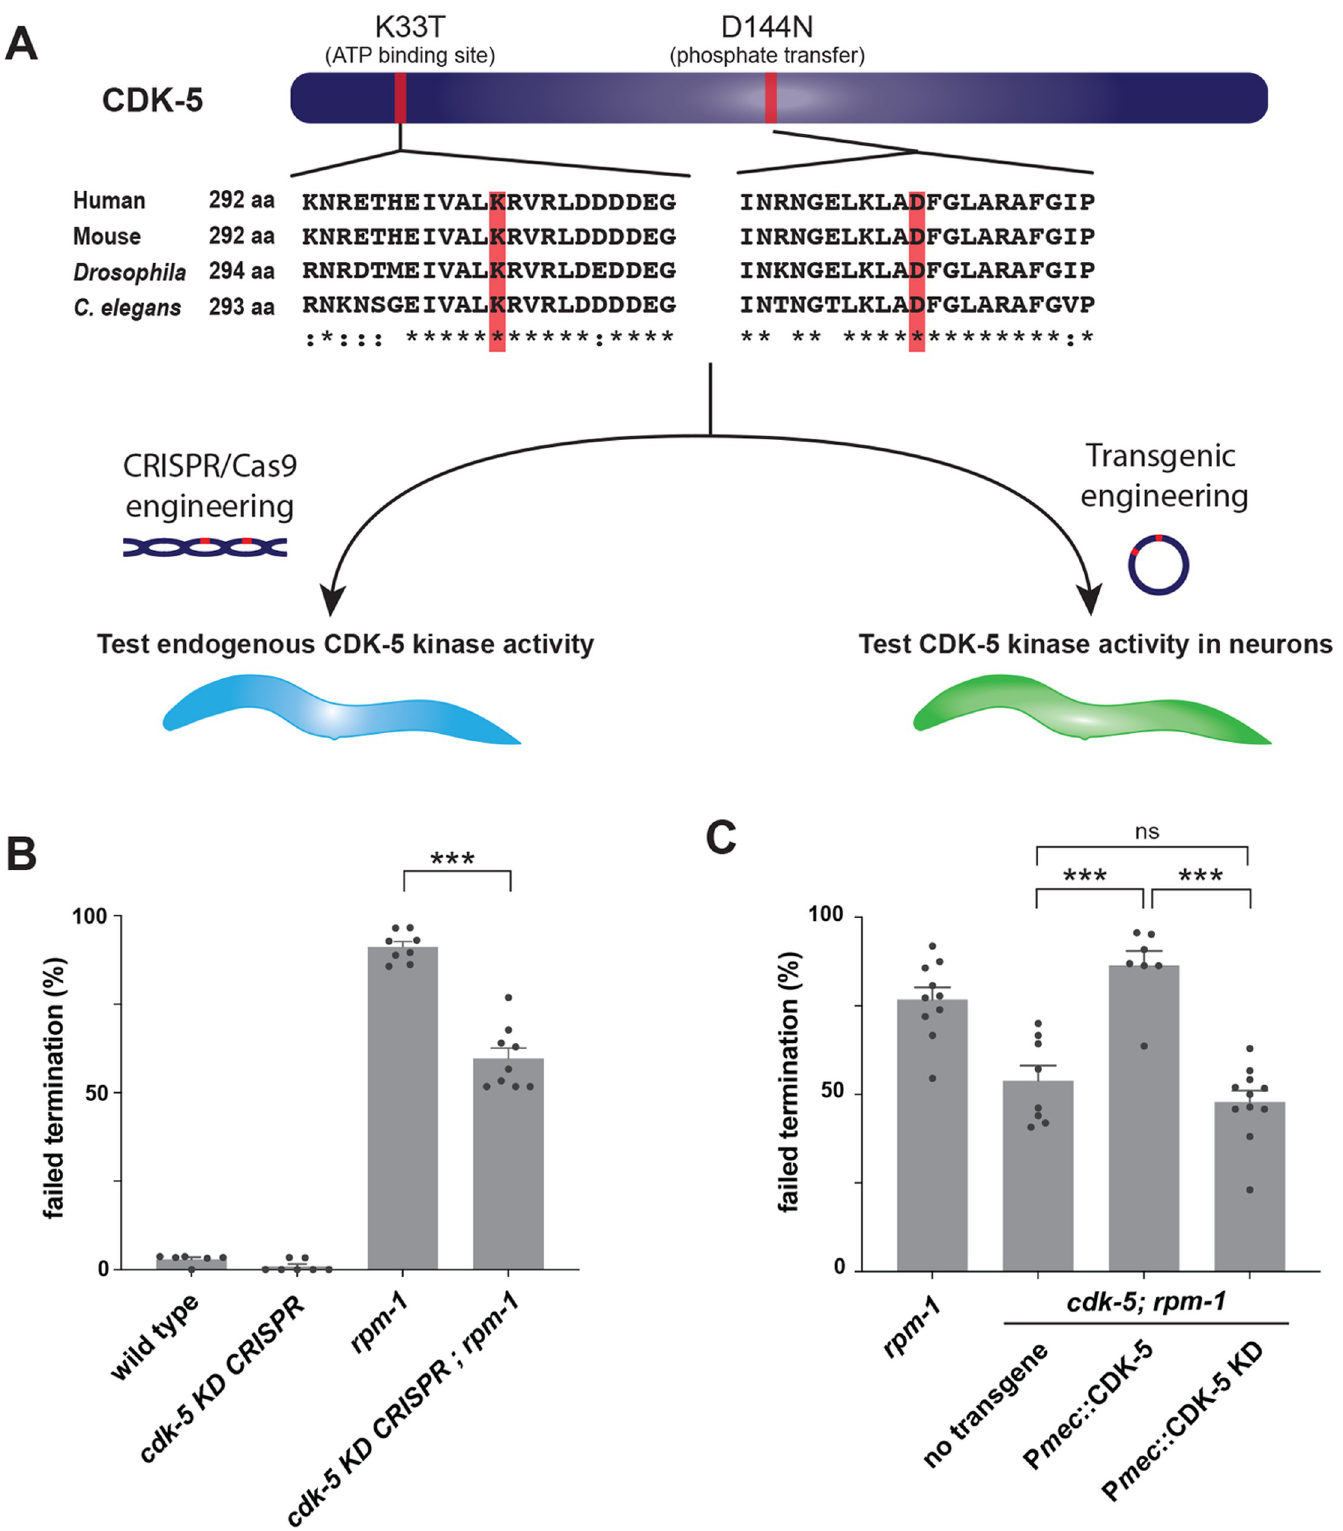
Fig 5. CRISPR editing and transgenics demonstrate RPM-1 restricts CDK-5 kinase activity. A ) Protein sequence alignment showing two conserved CDK-5 residues (red) mutated to inactivate kinase activity. Workflow for evaluating CDK-5 kinase activity using CRISPR/Cas9 editing or transgenic engineering. B ) CRISPR